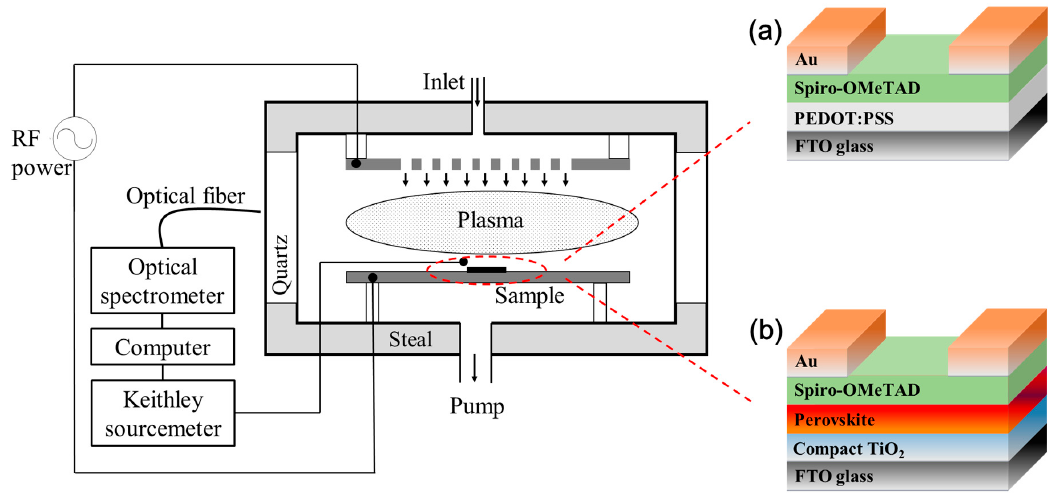
1 Figure 1. Schematics of the experimental setup used for the plasma-exposure of ( a ) hole-only device and ( b ) complete PSC device, optical emission spectrum measurement and charge mobility